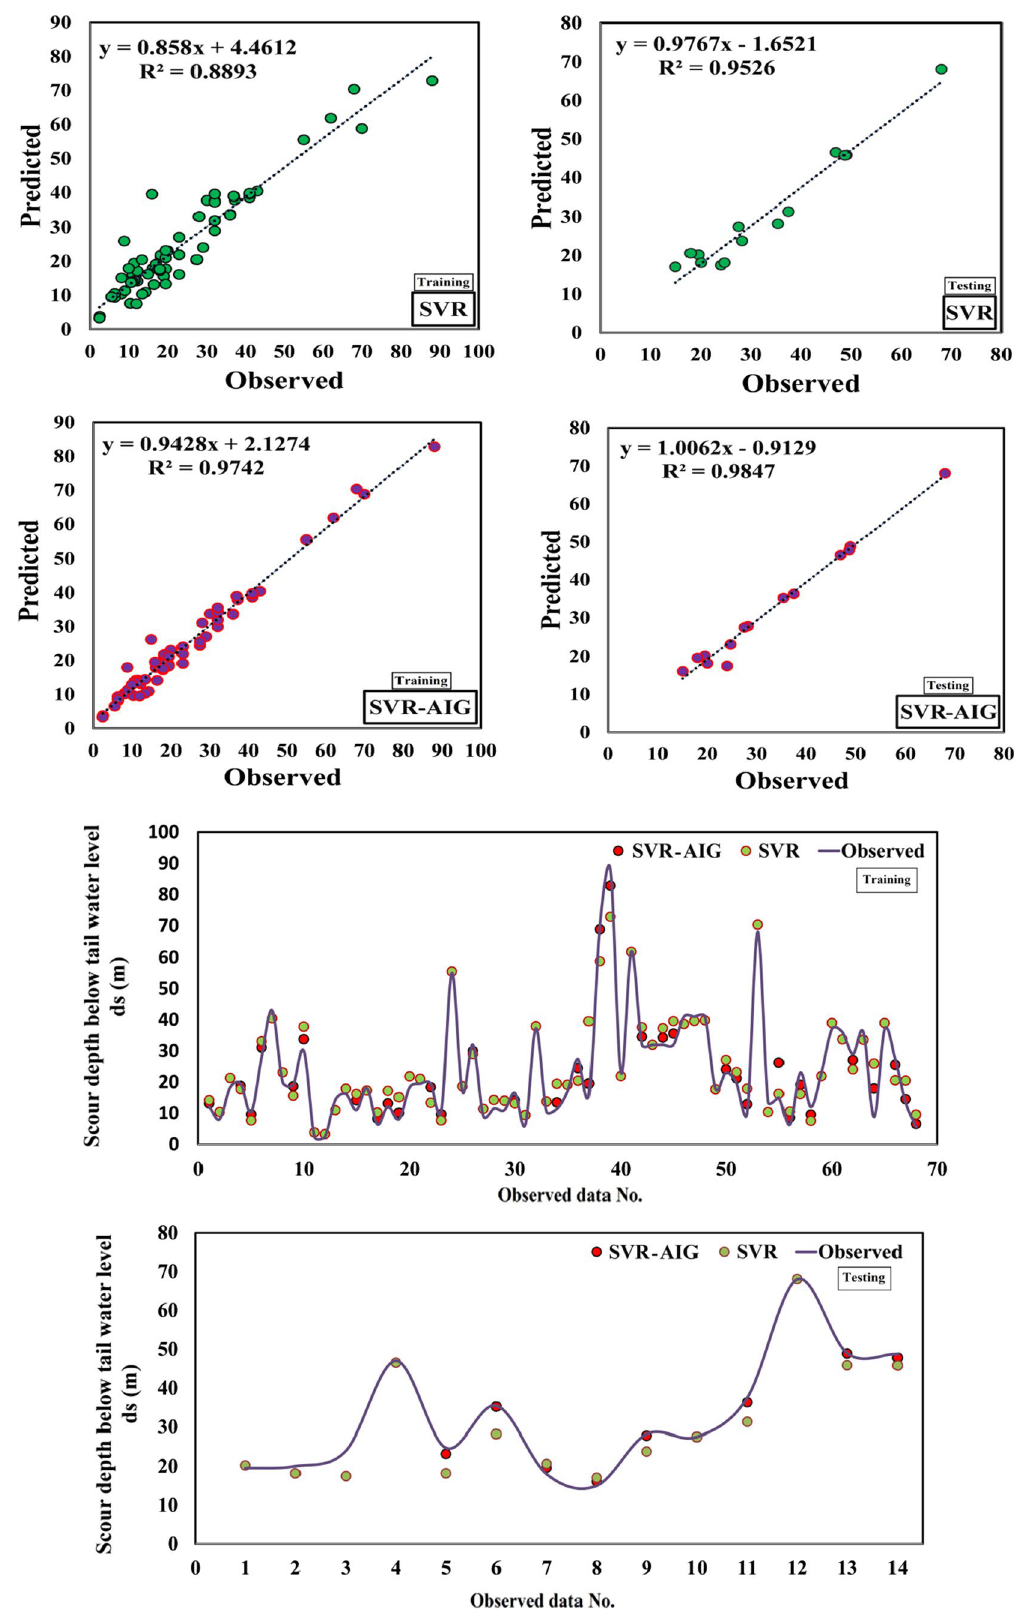
Fig. 4 Scatter plots and time series of the observed and predicted scour depth of the models for training and testing